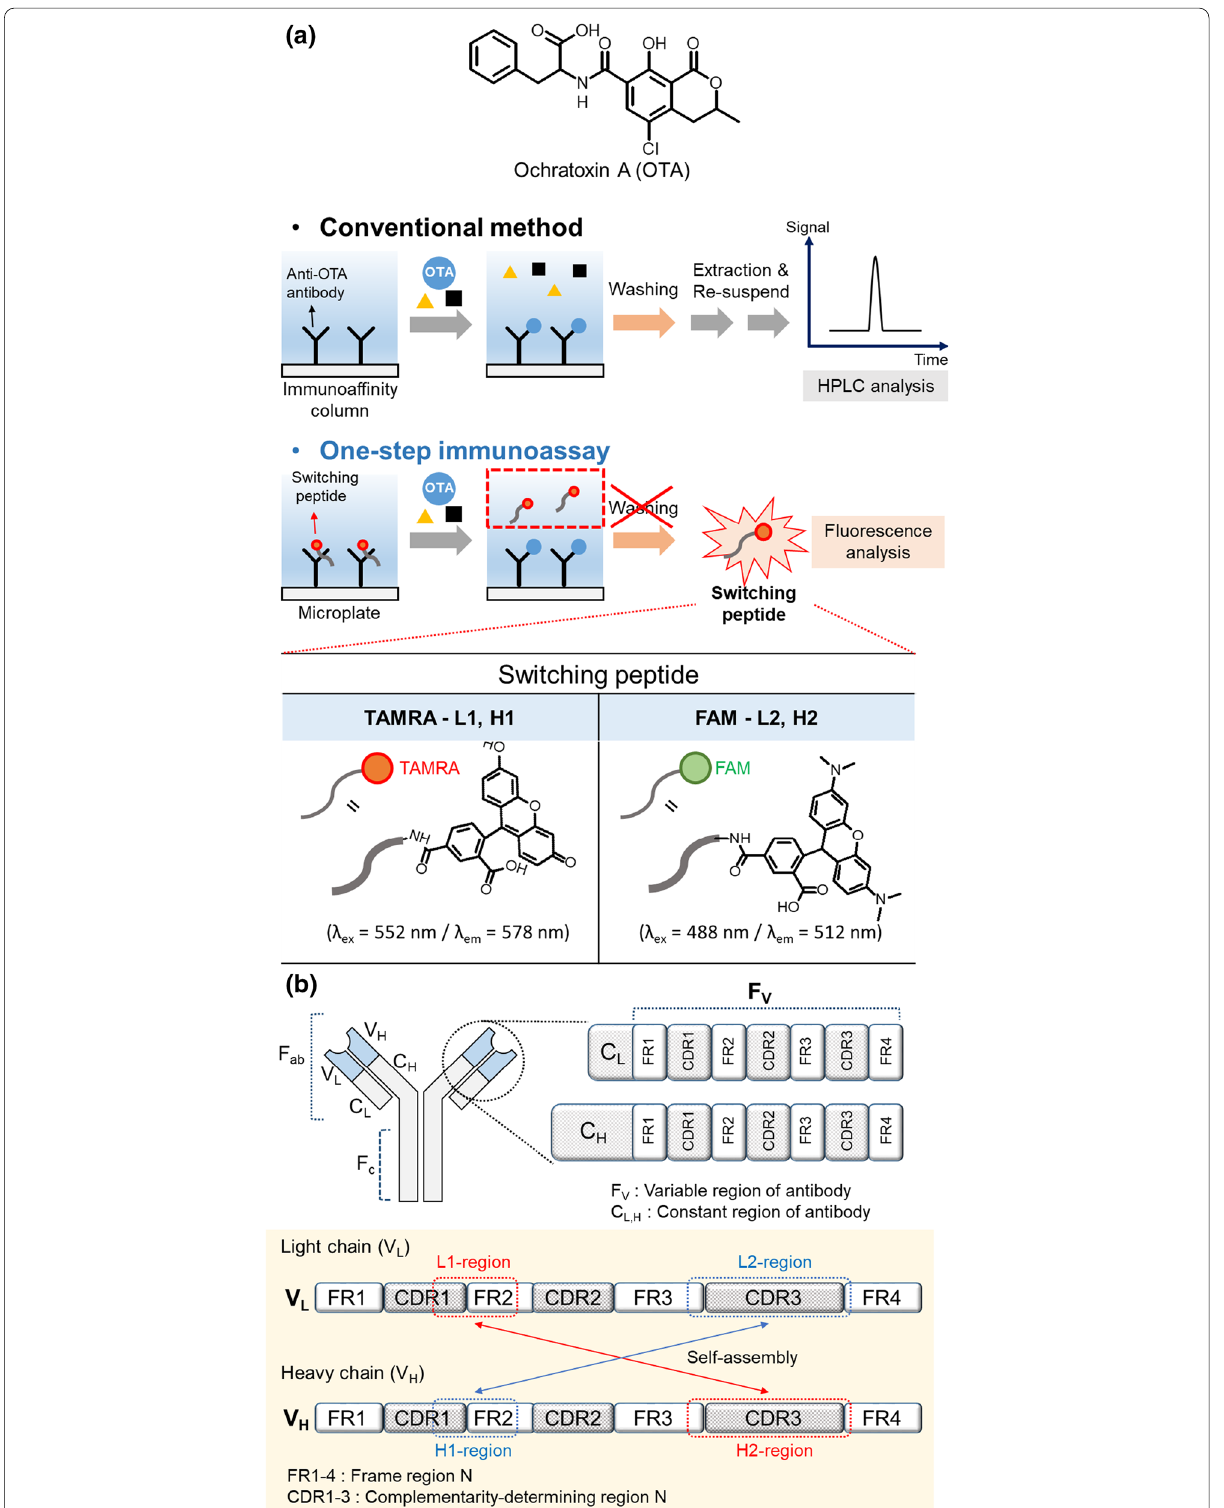
Fig. 1 One‑step immunoassay based on switching peptides. a Comparison of OTA detection configurations using one‑step immunoassay and conventional method. b Switching peptides that specifically bind to an antigen‑binding pocket of IgG. Binding pocket of IgG composed of heavy and light chains with complementarity‑determining regions (CDRs) and frame regions